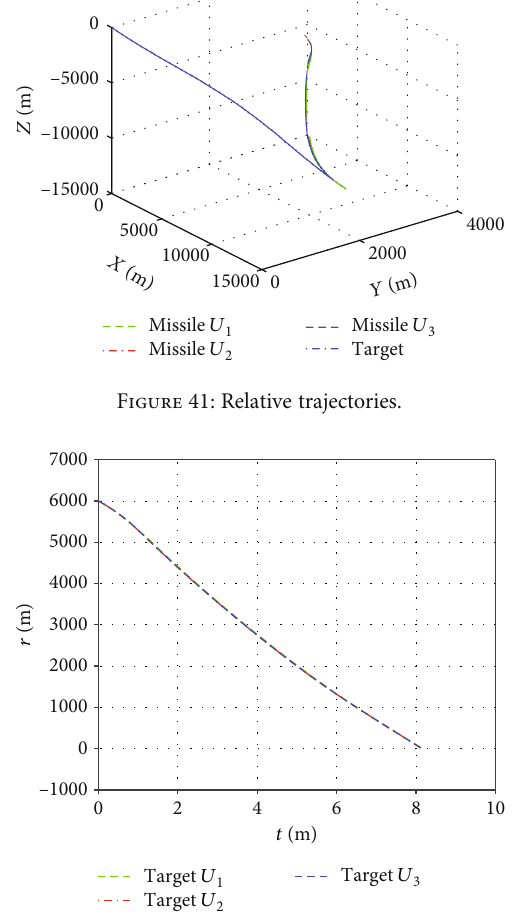
Figure 42: Ranges between the missile and the target.